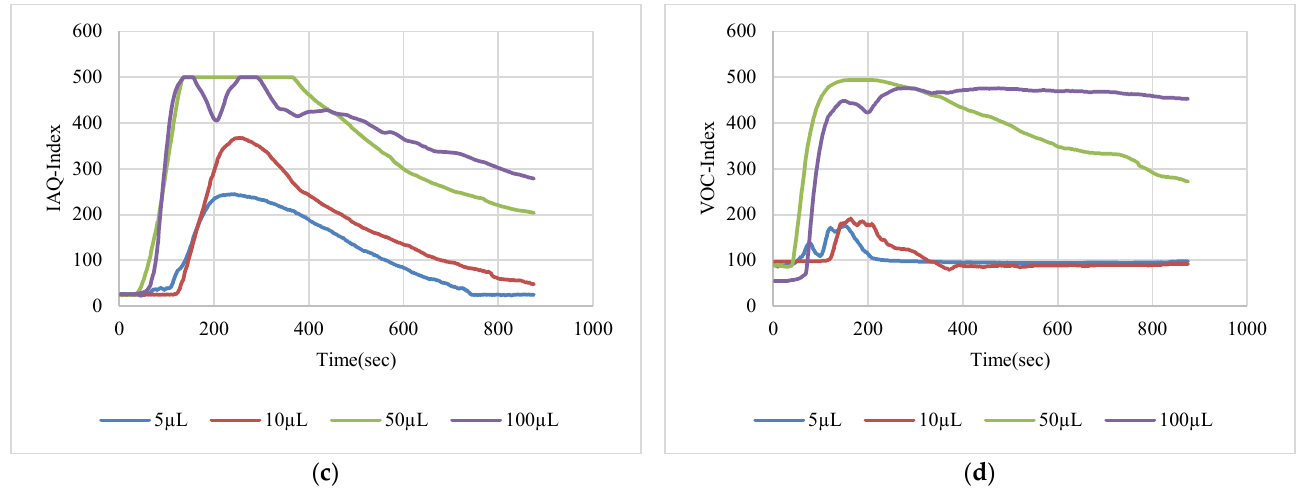
Figure 16. Test results for formic acid: ( a ) BME688 40 cm, ( b ) SGP41 40 cm, ( c ) BME688 100 cm, ( d ) SGP41 100 cm.